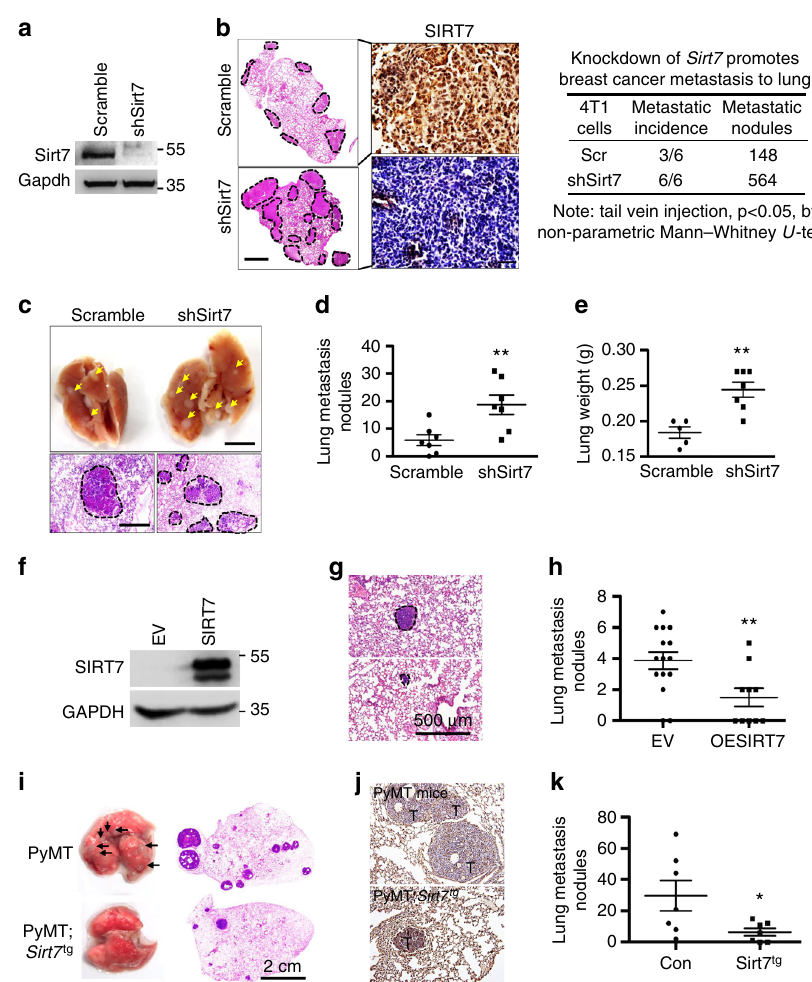
Fig. 2 SIRT7 inhibits breast cancer lung metastasis. a Immunoblots showing Sirt7 level in 4T1 cells expressing shSirt7. b Representative photos of murine lung sections showing metastatic nodules (hematoxylin & eosin staining) (H&E) and Sirt7 expression ( left ). Dotted lines indicate the metastatic lesions. Scale bar , 1 cm (H&E staining) and 100 μ m (IHC). Metastatic incidence and number of nodules were summarized ( right , n = 6 for each group). c Representative images of lung ( upper ) and H&E-stained lung sections ( lower ) showing spontaneous metastases generated from 4T1 cells after mammary fat pad injection. Dotted lines indicate metastatic lesions. Scale bar , 1 cm ( upper ) and 500 μ m ( lower ). d Scatter plot showing lung metastatic nodules ( n = 7 for each group). e Scatter plot showing the wet weight of lungs in c . f Immunoblots of SIRT7 in control (empty vector, EV) and SIRT7-overexpressing MDA-MB-231 cells (OESIRT7). g Representative H&E-stained lung sections. Dotted lines highlight the metastatic lesions. Scale bar , 500 μ m. h Scatter plot showing lung metastatic nodules from animals injected with EV or OESIRT7 cells ( n = 13 and 10, respectively). i Representative images of lung ( left ) and H&E-stained lung sections ( right ) from spontaneous metastases generated in PyMT or PyMT; Sirt7 tg mice after doxycycline feeding. Scale bar , 2 cm. j Representative IHC staining of Sirt7 in lungs of PyMT or PyMT; Sirt7 tg mice after doxycycline feeding. Scale bar , 100 μ m. k Scatter plot showing the lung metastatic nodules from control ( n = 7) or PyMT; Sirt7 tg mice ( n = 7). * P < 0.05, ** P < 0.01. P- values were obtained by non-parametric Mann – Whitney U -test d , h , k or Student ’ s t -test e . Data are shown as mean ± S.E.M. and representative of two independent H3K122 to regulate chromatin remodeling during DNA repair 20 . SIRT7 also interacts with mTOR and GTF3C1, a component of the Pol III transcription factor TFIIIC2 complex, to regulate protein synthesis 21 , and cooperates with Myc to suppress ribosome biogenesis 22 . Loss of Sirt7 in mice causes genomic instability and accelerated aging 23 . Here, utilizing various mouse models and human clinical samples, we uncover a unique function of SIRT7 in suppressing EMT and metastasis via TGF- β signaling. SIRT7 deacetylates and promotes the degradation of SMAD4. SIRT7 is downregulated during metastasis, and predicts lung metastasis-free survival of breast cancers. Resveratrol directly activates SIRT7 deacetylase to suppress TGF- β signaling, thus inhibiting breast cancer metastasis. Our data identify SIRT7 as a novel anti-metastatic therapeutic target and resveratrol as a candidate molecule with potential anti-metastatic bene fi ts.